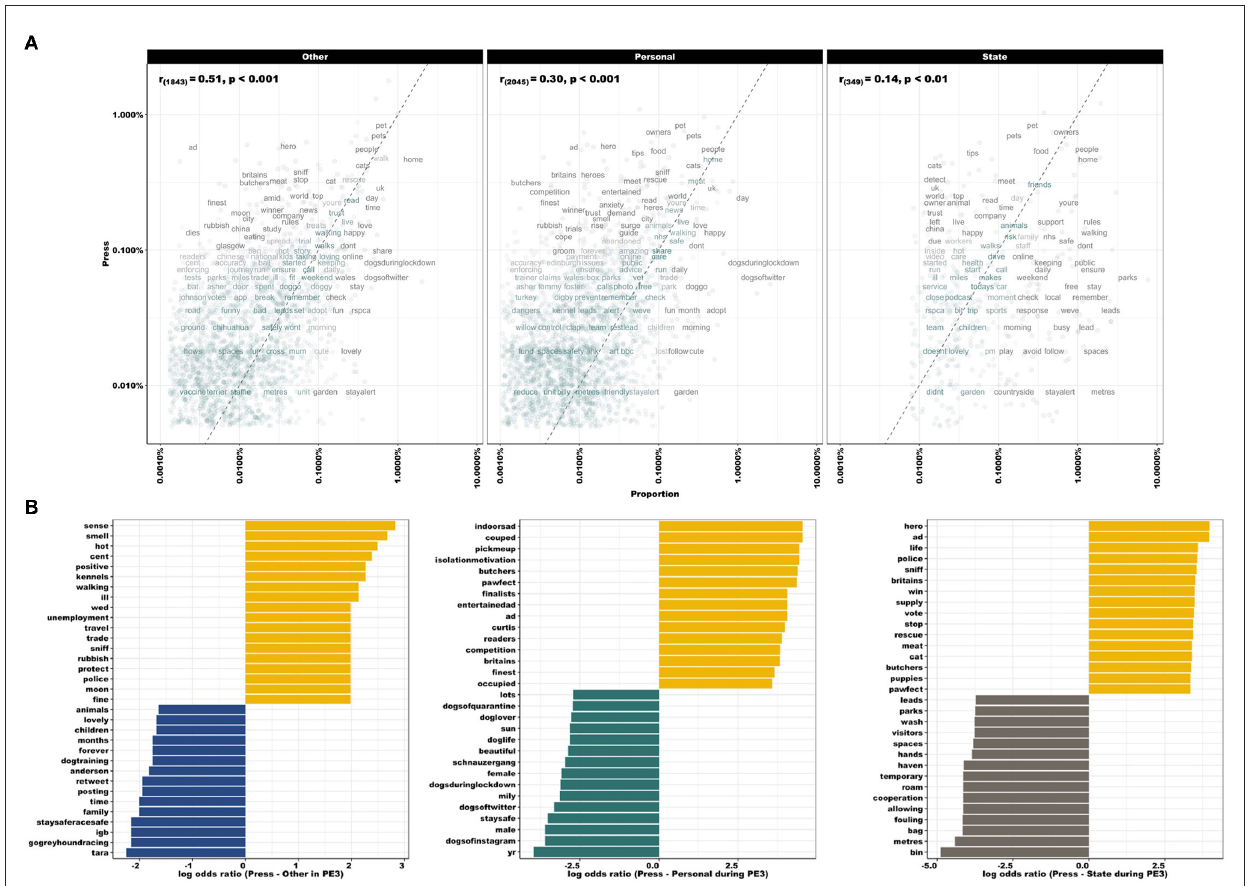
FIGURE5 (A) Comparing word frequencies of Press with all other sectors (Other, Personal, and State), across the full period (March 27th–August 22nd, 2020). Pearson correlation coefficient noted in top left of panel. Words close to the zero-slope line have similar frequencies in both sets of texts, e.g., “people” and “home” are located at the upper frequency for all pairings. Words that are far from the line identify those that are found more in one set of texts than another. Empty space at low frequencies within Press-State panel indicates that these sectors use more dissimilar wording than Press-Other and Press-Personal (also represented by correlation coefficient). However, also note fewer data points in the Press-State panel. (B) Log odds ratios comparing word usage during PE3, between Press (yellow) and all other sectors (Other: blue, Personal: green, State: gray). Note increased use of language related to mental health, meat trade and employment, e.g., “indoorsad”, “couped”, “isolationmotivation”, “meat”, “trade”, and “unemployment”.